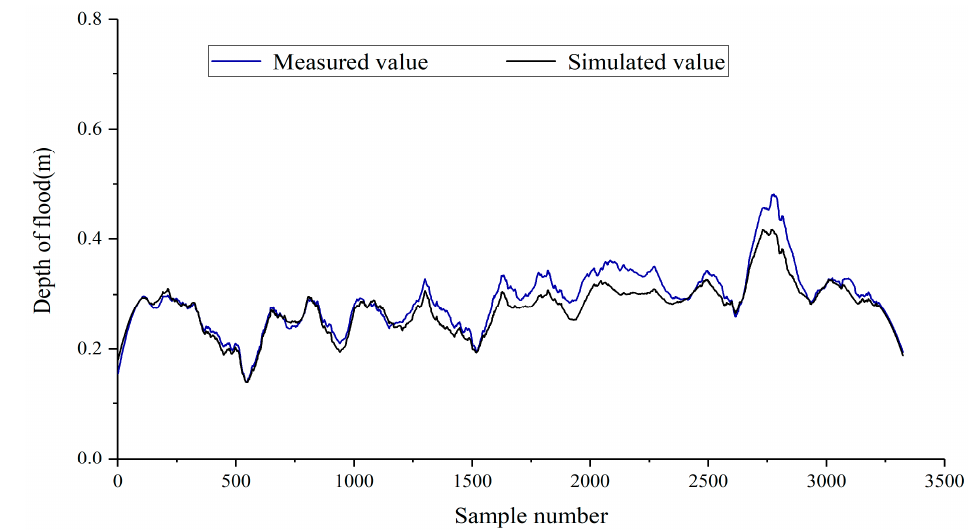
Figure 4. Fitting curves between simulated and measured values (5 August 2016). Table 3. The value of the evaluation